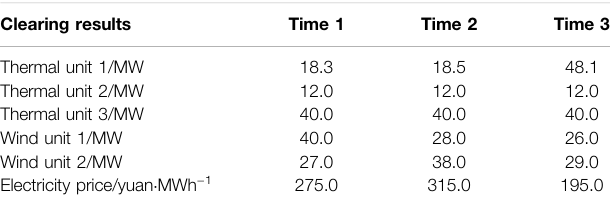
TABLE 3 | Market-clearing energy of the proposed model considering security constraints.